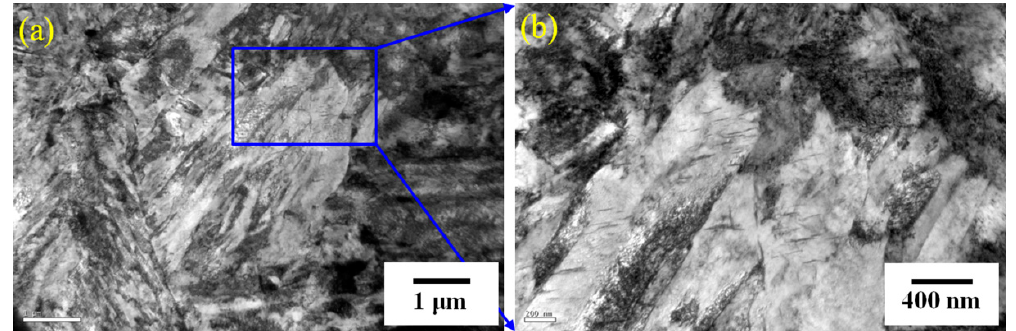
Figure 5. Transmission electron micrographs of the FPM190 sample. The blue area in ( a ) is partially enlarged in ( b ), showing the floc-like carbides existing in the martensite lath.